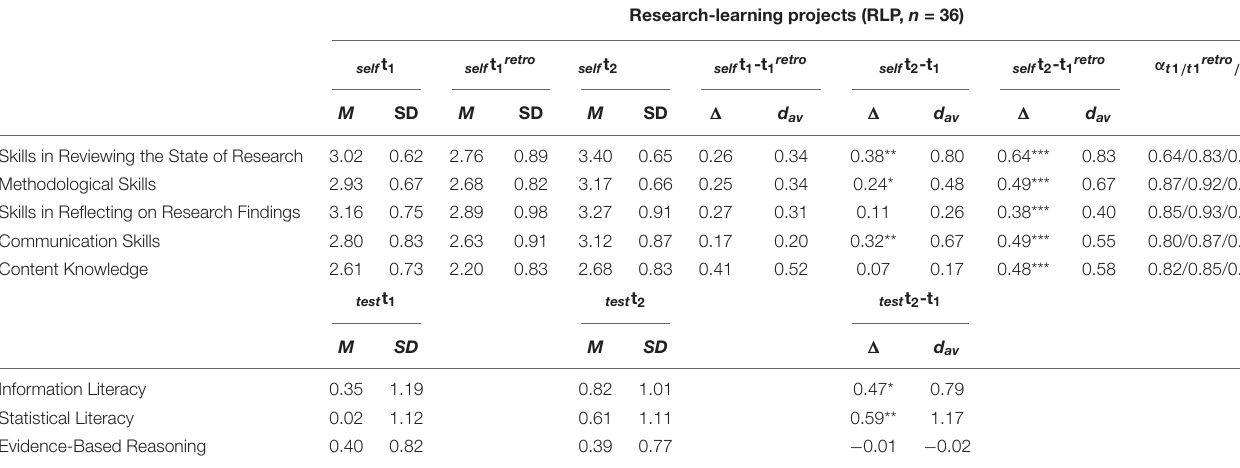
TABLE 4 | Mean values, standard deviations, differences in mean values, effect sizes, and Cronbach’s